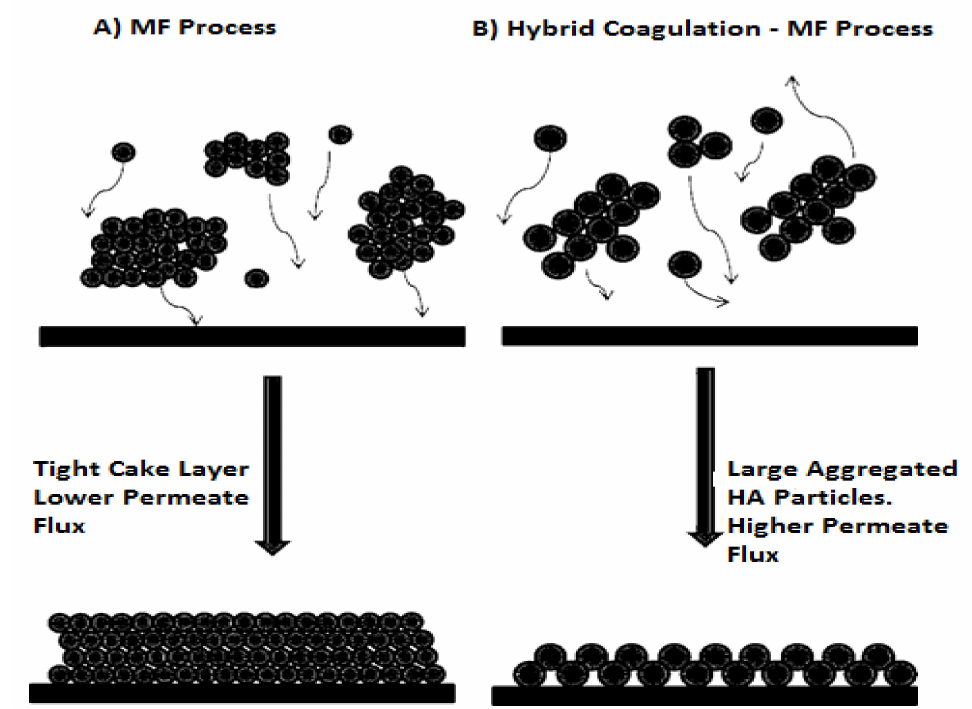
Figure 7. Schematic of cake layer formation for MF ( A ) and hybrid coagulation–MF processes ( B )